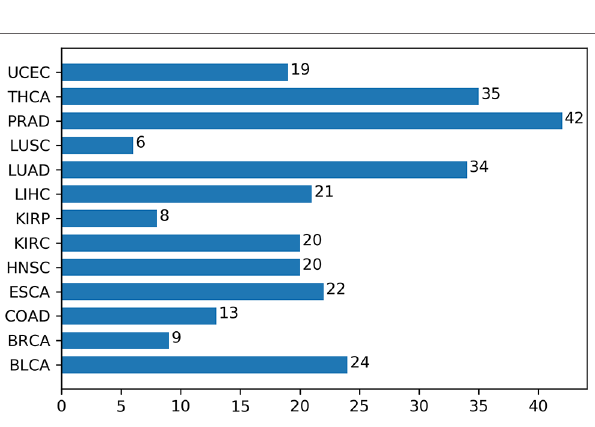
FIGURE 7 | The number of metabolic pathways for DML-associated genes in each